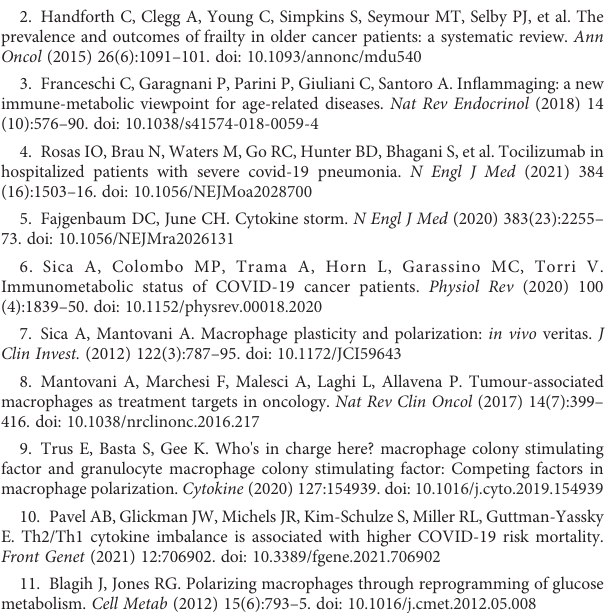
SUPPLEMENTARY TABLE 1 List of modulated lipids in PBMCs with fold changes (FC) and p -values. SUPPLEMENTARY TABLE 2 List of modulated proteins in PBMCs with fold changes (PC) and p -values. SUPPLEMENTARY TABLE 3 List of identi fi ed and modulated small molecules in plasma with fold changes (FC) and p -values. SUPPLEMENTARY TABLE 4 Tumor types in COV/CA and CA patients. SUPPLEMENTARY TABLE 5 Prediction score of the canonical pathway analysis performed on proteomic data. SUPPLEMENTARY FIGURE 1 Modulation of lipids and NAD in COVID-19 patients. (A) Box-plot plot of LPC 18:0 (left) and LPE O-18:1 (right) concentration in healthy subjects HD), cancer patients (CA), mild and severe COVID-19 patients (COV), and mild andseverepatients withCOVID-19andcancer (COV/CA). (B) Box-plotplotof total ceramide concentration). (C) Box-plot plot of the concentration of the nicotinamide adenine dinucleotide (NAD) precursor nicotinamide. * P < 0.05, ** P < 0.01, *** P < 0.001, **** P < 0.0001. SUPPLEMENTARY FIGURE 2 Box-plot plot of proteins involved in the main pathways modulated in cancer patients with COVID-19. Integrin signaling: actin (A) , ADP-ribosylation factor 4 (B) , Ras-related C3 botulinum toxin substrate 2 (C) . EIF2 signaling: growth factor receptor-bound protein 2 (D) , 60S ribosomal protein L26-like 1 (E) .